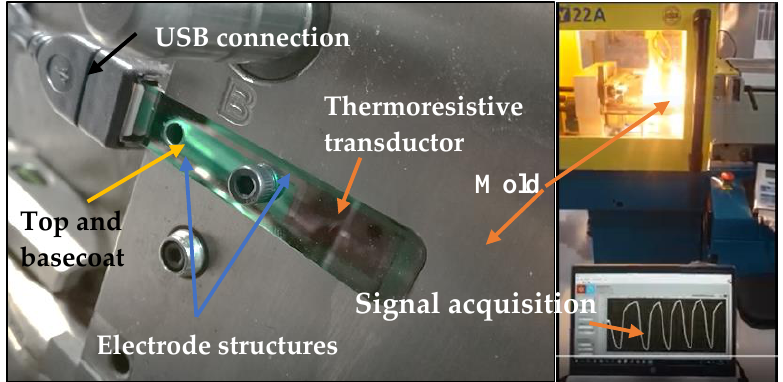
Figure 9. Integrated steel insert with the different layers, top-coat, base-coat, thermoresistive transducer and electrodes, placed in the mold surface.